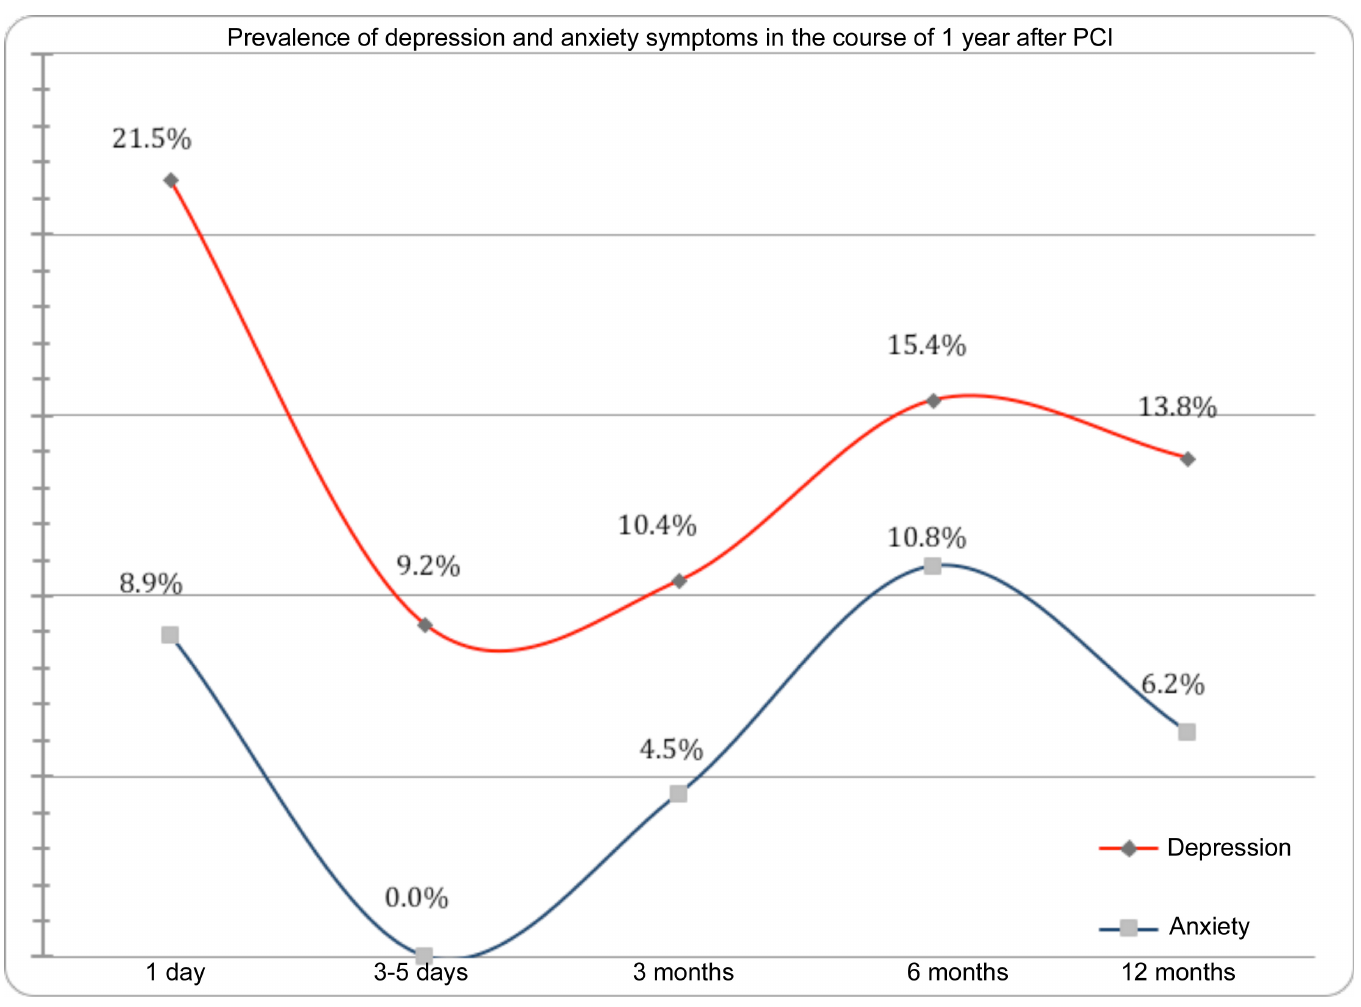
Fig 1. Prevalence of depression and anxiety symptoms in the course of 1 year after